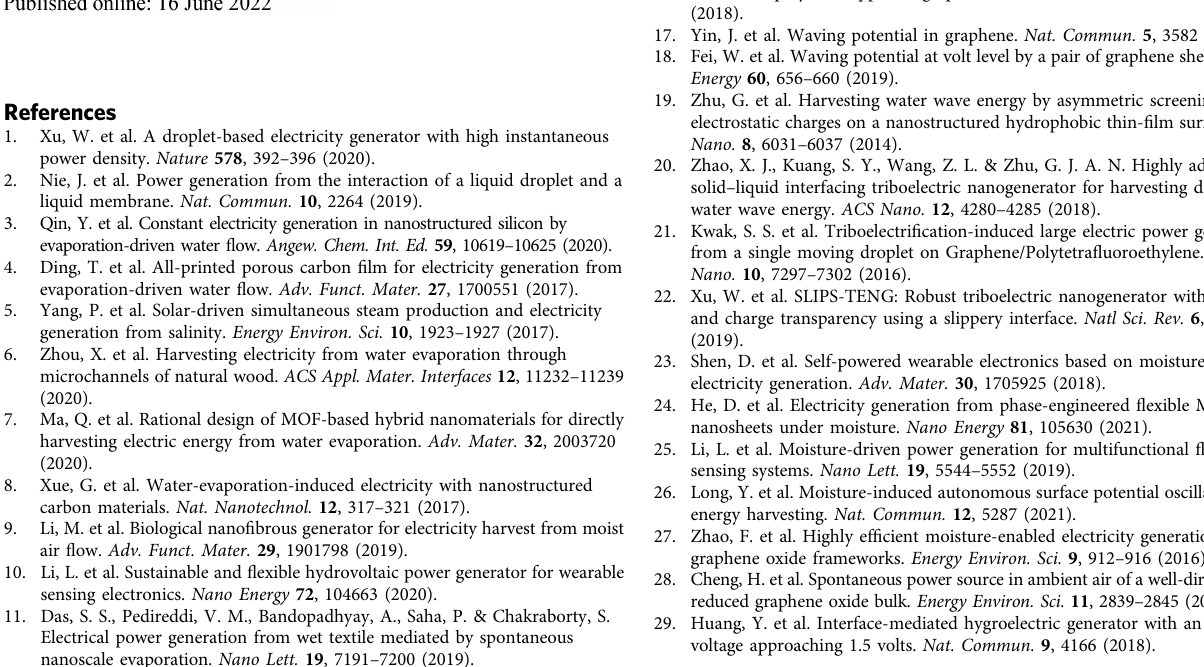
Data availability